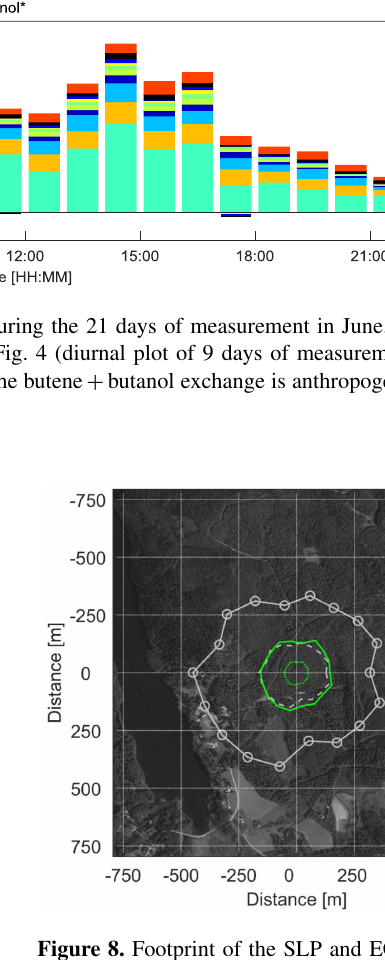
Figure 8. Footprint of the SLP and EC method. The higher nom- inal measurement height of the SLP fluxes increases the footprint drastically, when compared to the EC measurements. This could be a possible cause for the discrepancies in the